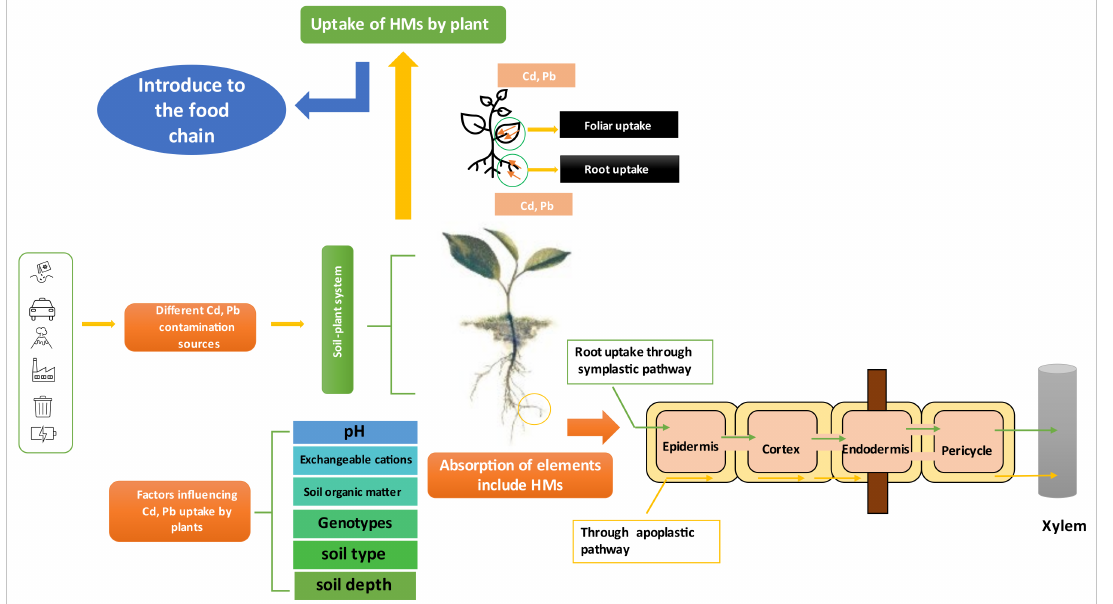
Figure 4. Cadmium and lead contamination pathways towards soil-plant system under the influence of different factors (apoplastic pathway through cell wall, symplastic through